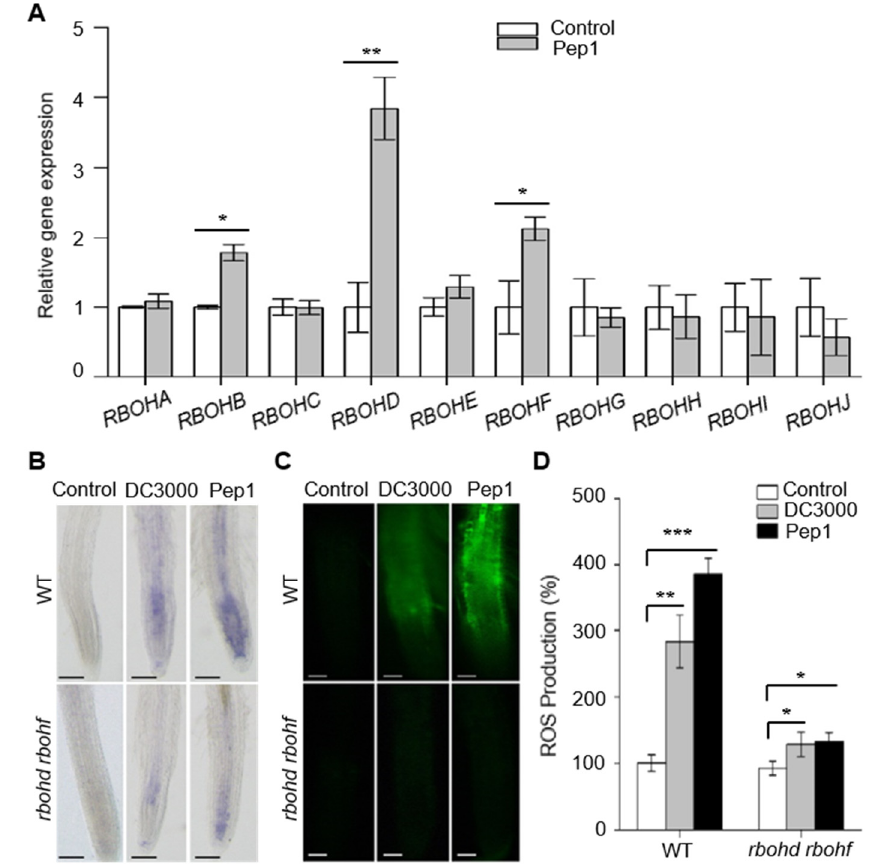
Figure 3. RBOHD and RBOHF are required in pathogen and Pep1-induced ROS production. ( A ) The transcriptional level of RBOHs in wild type (WT) roots upon Pep1 treatment. Two-week-old WT seedlings were incubated in half-strength MS liquid medium with or without (control) 1 µ M Pep1 for 4 h. The expression level of control (0 h) was set as 1.0 and Pep1 treatment levels were normalized to the control level. Data are means ± SD ( n = 3). ( B ) NBT staining of superoxide (O 2 − ) anion in WT and rbohd rbohf roots. Bars = 100 µ m. ( C ) H 2 DCF-DA staining of H 2 O 2 in WT and rbohd rbohf roots. Bars = 100 µ m. In ( B , C ), the six-day-old seedlings were incubated in half-strength MS liquid medium (control) or medium with DC3000 (initial OD 600 of 0.02) or Pep1 (1 µ M) added for 18 h. ( D ) The statistical analysis of the ROS production in WT and rbohd rbohf roots as shown in ( C ). Data are means ± SD from three independent experiments. ( n = 30). The relative ROS production of each treatment was normalized to the control of WT roots (100%). Asterisks in ( A , D ) indicate statistically significant differences compared with the controls (Tukey’s test, * p < 0.05, ** p < 0.01, *** p < 0.001).